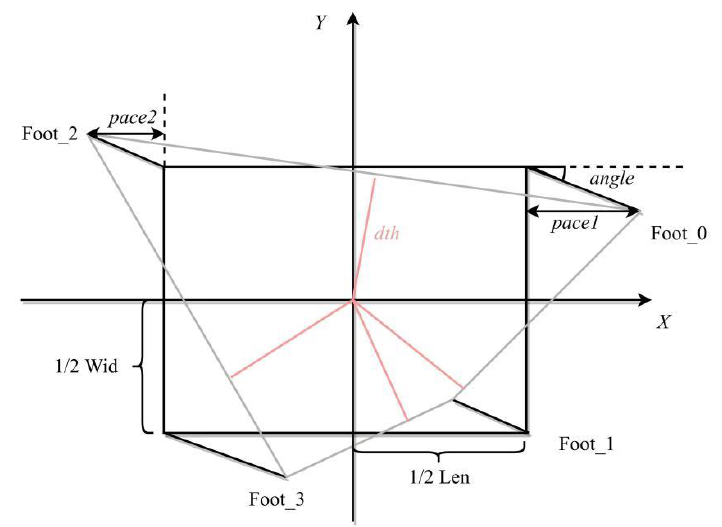
Figure 6. Schematic diagram of robot ’ s leg-end fall point, where 𝑊𝑖𝑑 is the body width; 𝑝𝑎𝑐𝑒1, 𝑝𝑎𝑐𝑒2 are the forward moving distance of swing phase and the backward moving distance of support phase, respectively; 𝑑𝑡ℎ is the distance between the center of gravity and the line connecting the foot end; and 𝑎𝑛𝑔𝑙𝑒 is the driving leg internal offset angle.